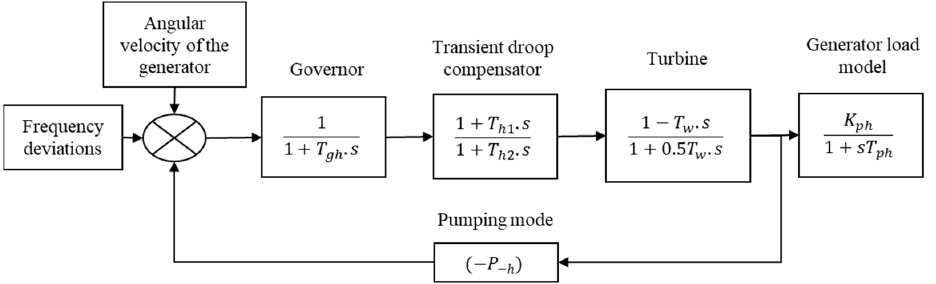
Figure 4. The pump-hydro unit is obtained via the following transfer function representation